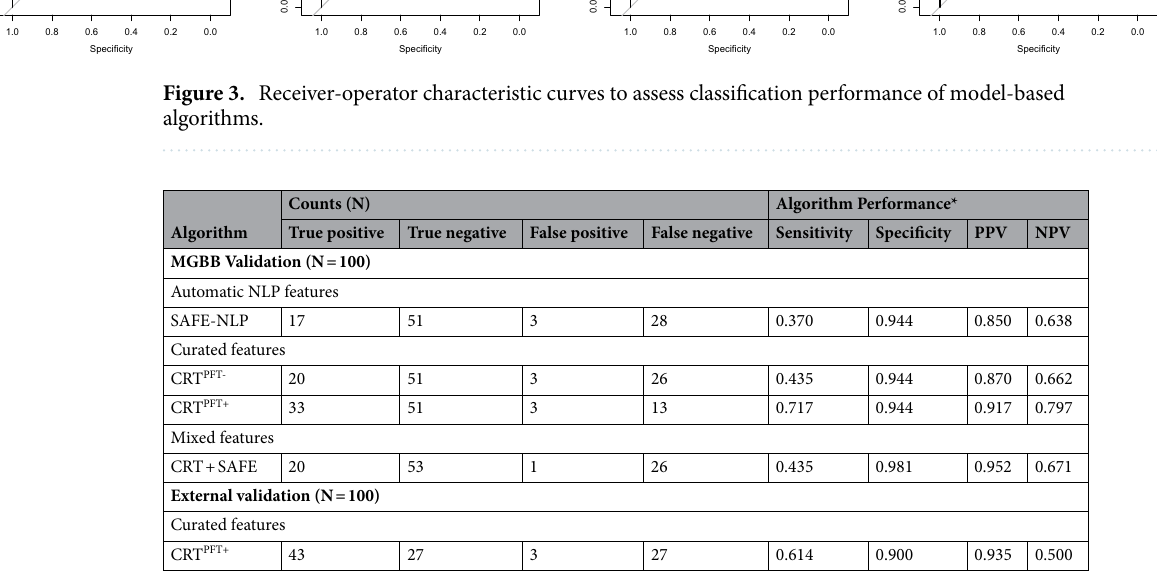
Table 3. Comparison of performance characteristics of probabilistic electronic medical record COPD classification algorithms within Mass General Brigham Biobank validation set (N = 100) and